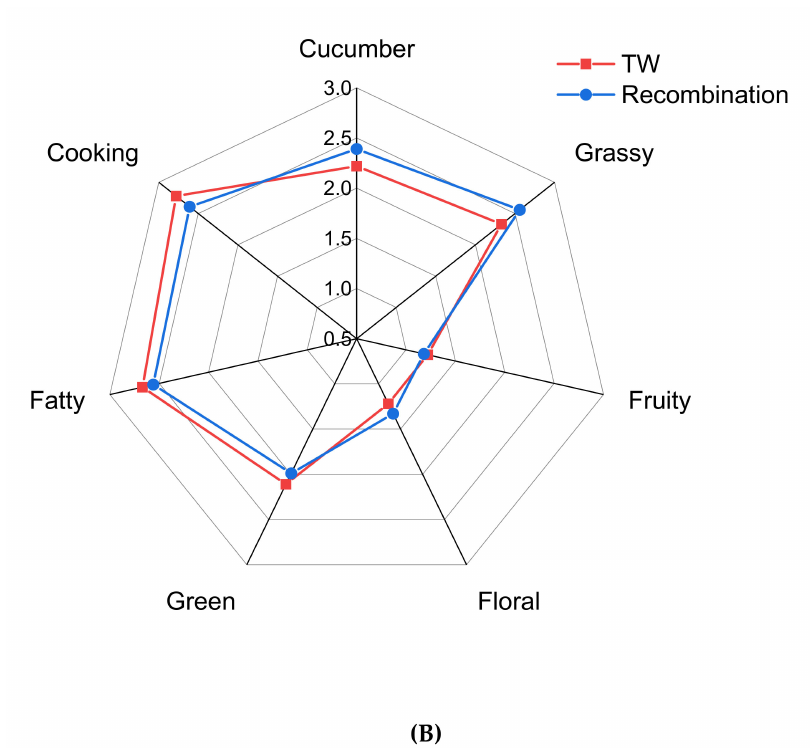
Figure 1. Odor attributes of FW and TW ( A ) and aroma profile of TW and recombination system ( B ) by sensory evaluation.